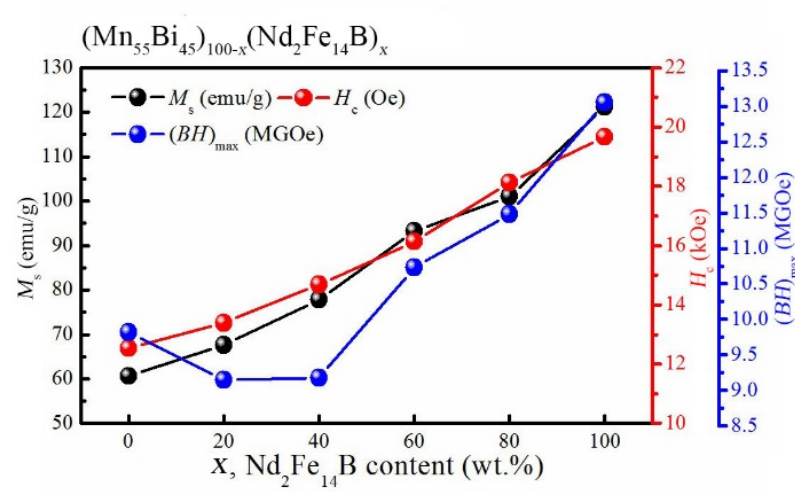
Figure 3. The room temperature hysteresis loops of the bulk (Mn 55 Bi 45 ) 100 − x /(Nd 2 Fe 14 B) x ( x = 0, 20, 40, 60, 80, and 100) hybrid magnetic alloys.